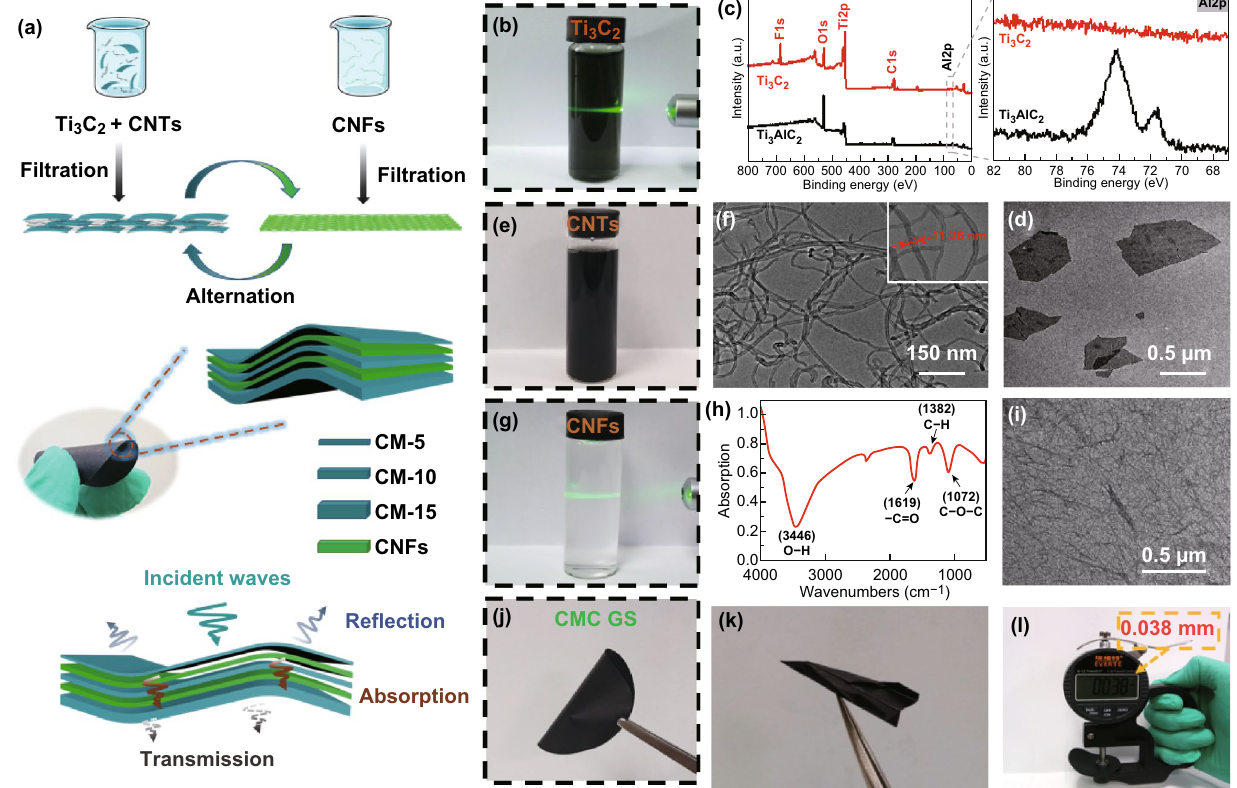
Fig. 1 a Schematic illustrating the fabrication of CMC GS composite paper. b Digital image, c XPS spectra, and d TEM image of Ti 3 C 2 MXene. e Digital image and f TEM image of CNTs. g Digital image, h FTIR spectra, and i TEM image of CNFs. j – l Digital images of the